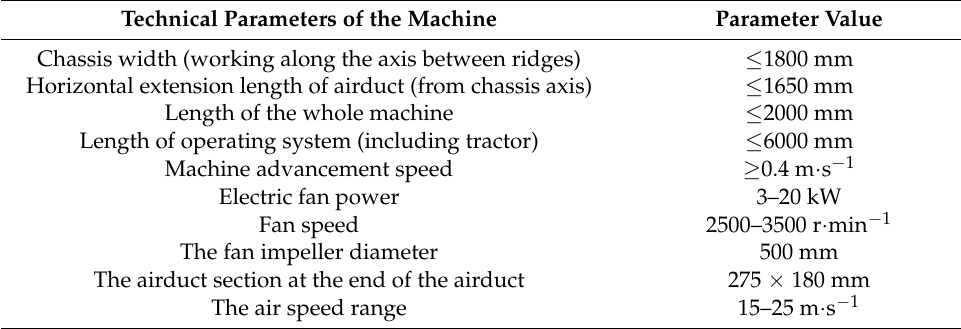
Table 1. Technical parameters of the machine. Technical Parameters of the Machine Parameter Value Chassis width (working along the axis between ridges) ≤ 1800 mm Horizontal extension length of airduct (from chassis axis) ≤ 1650 mm Length of the whole machine ≤ 2000 mm Length of operating system (including